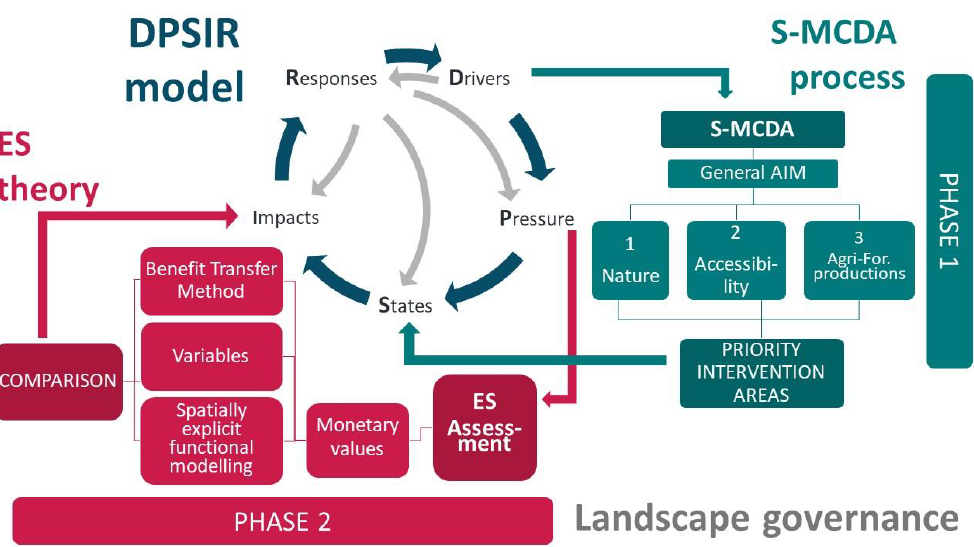
Figure 2. The framework of